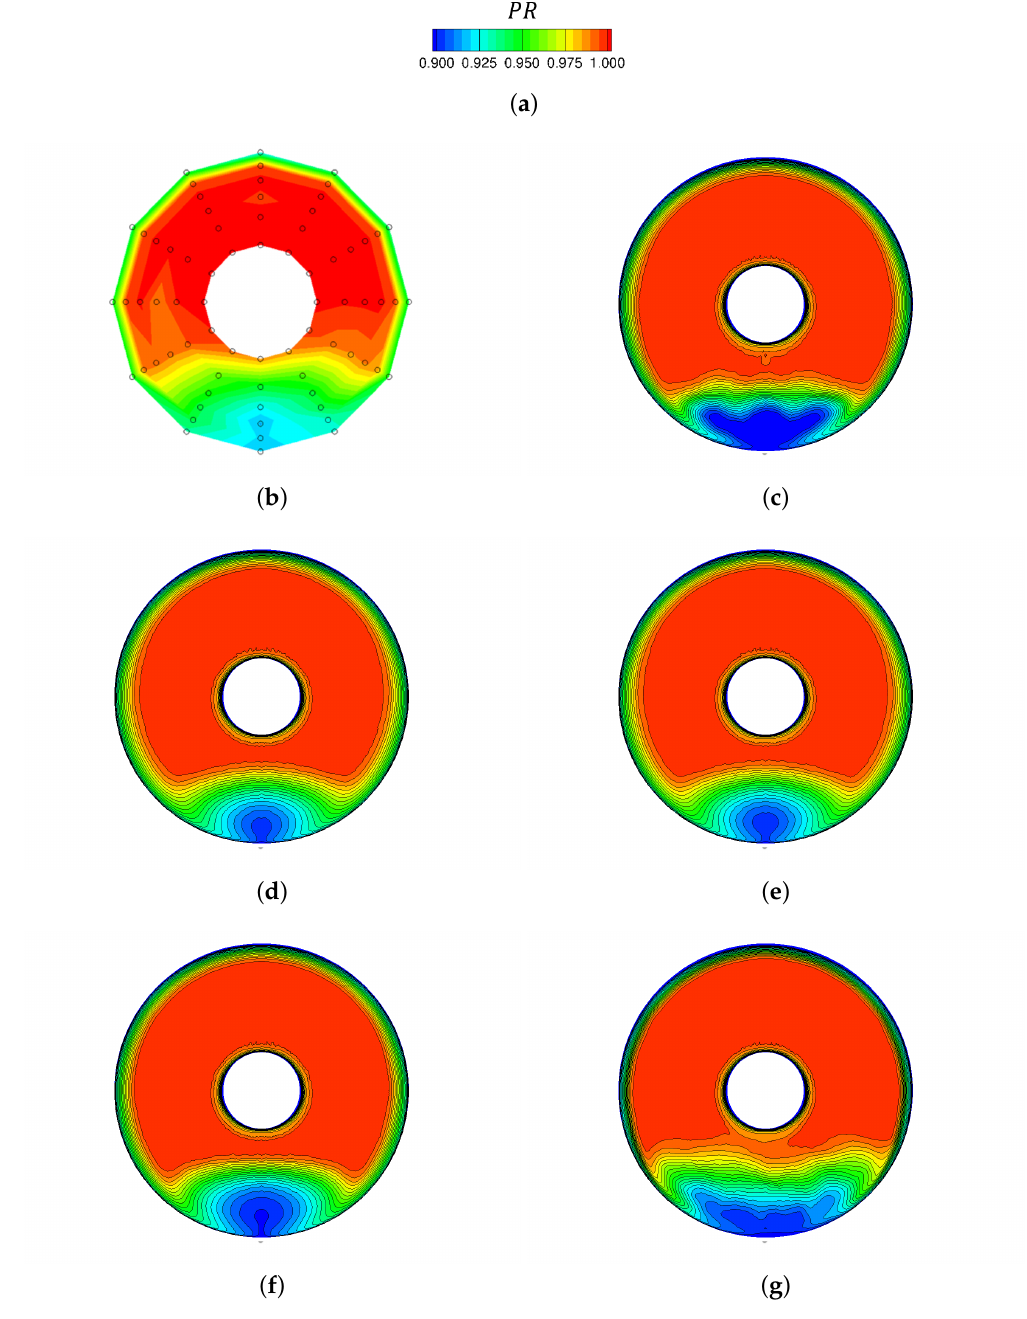
Figure 9. Effects of turbulence model on engine face pressure ratio. Time-averaged solutions are shown for the NASA baseline grid. ( a ) Pressure recovery range; ( b ) Experimental data; ( c ) CFD–SARC + DDES; ( d ) CFD–SA; ( e ) CFD–SARC; ( f ) CFD–Menter SST; ( g ) CFD–Menter SST +